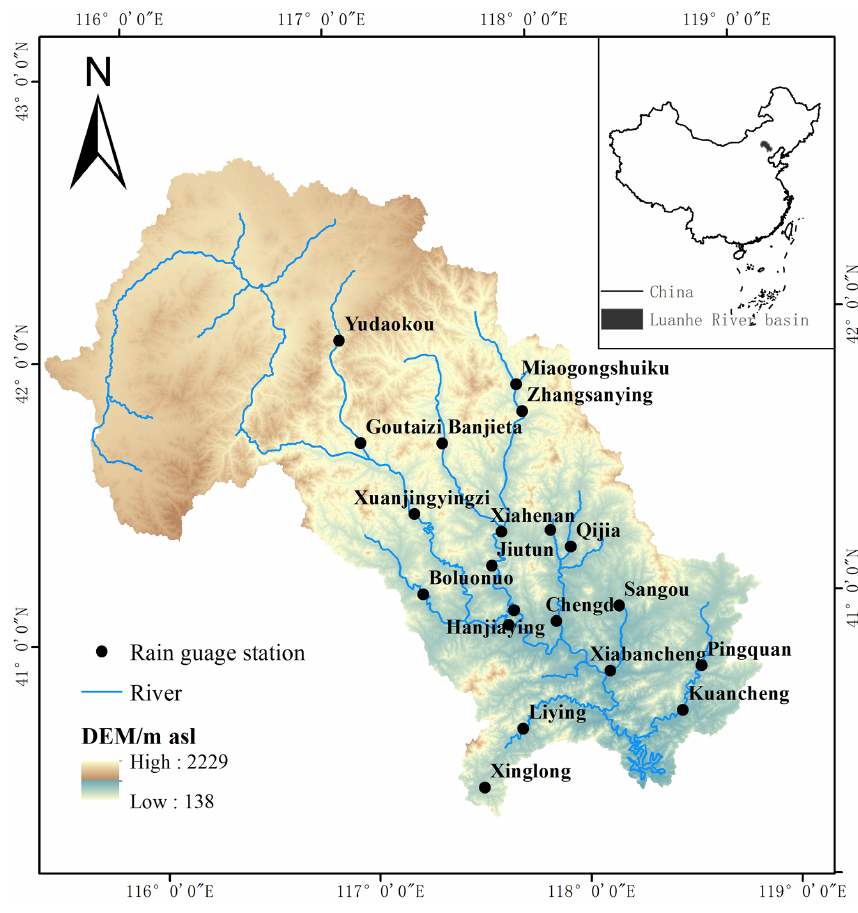
Figure 1. The geographical location of the Luanhe River